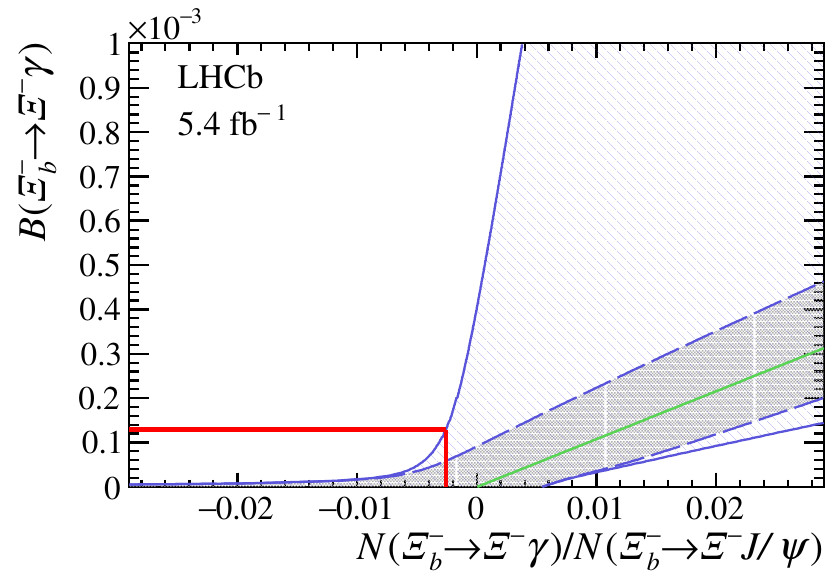
Figure 5 . Confidence interval at 95% CL showing the upper limit for B ( Ξ − Ξ − → Ξ − γ ) of the N ( ratio. The green line represents the relation between the yield and the b − → Ξ − J/ψ ) N ( Ξ b branching fractions. The interval considering only the statistical uncertainty is shown by the dashed blue lines, while the full blue lines also includes the systematic uncertainties. The measured ratio of the yields and the upper limit on the branching fraction are represented by the red